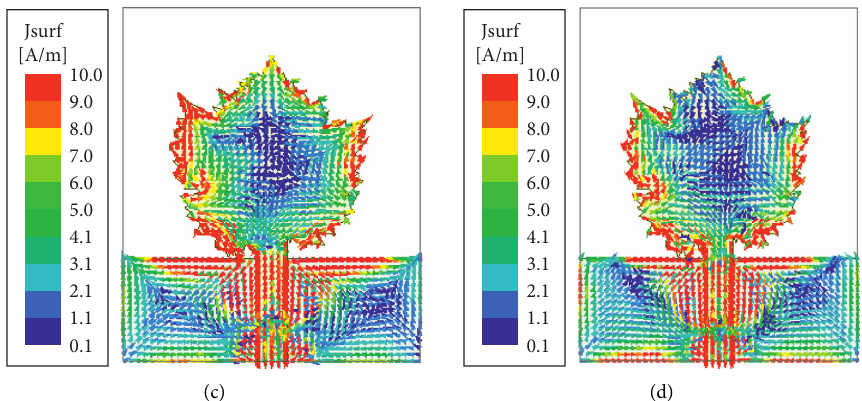
Figure 14: Simulated vector surface current distribution of the proposed VBi-UWBA at (a) 4.6 GHz, (b) 8 GHz, (c) 10.8 GHz, and (d) 11.5 GHz.